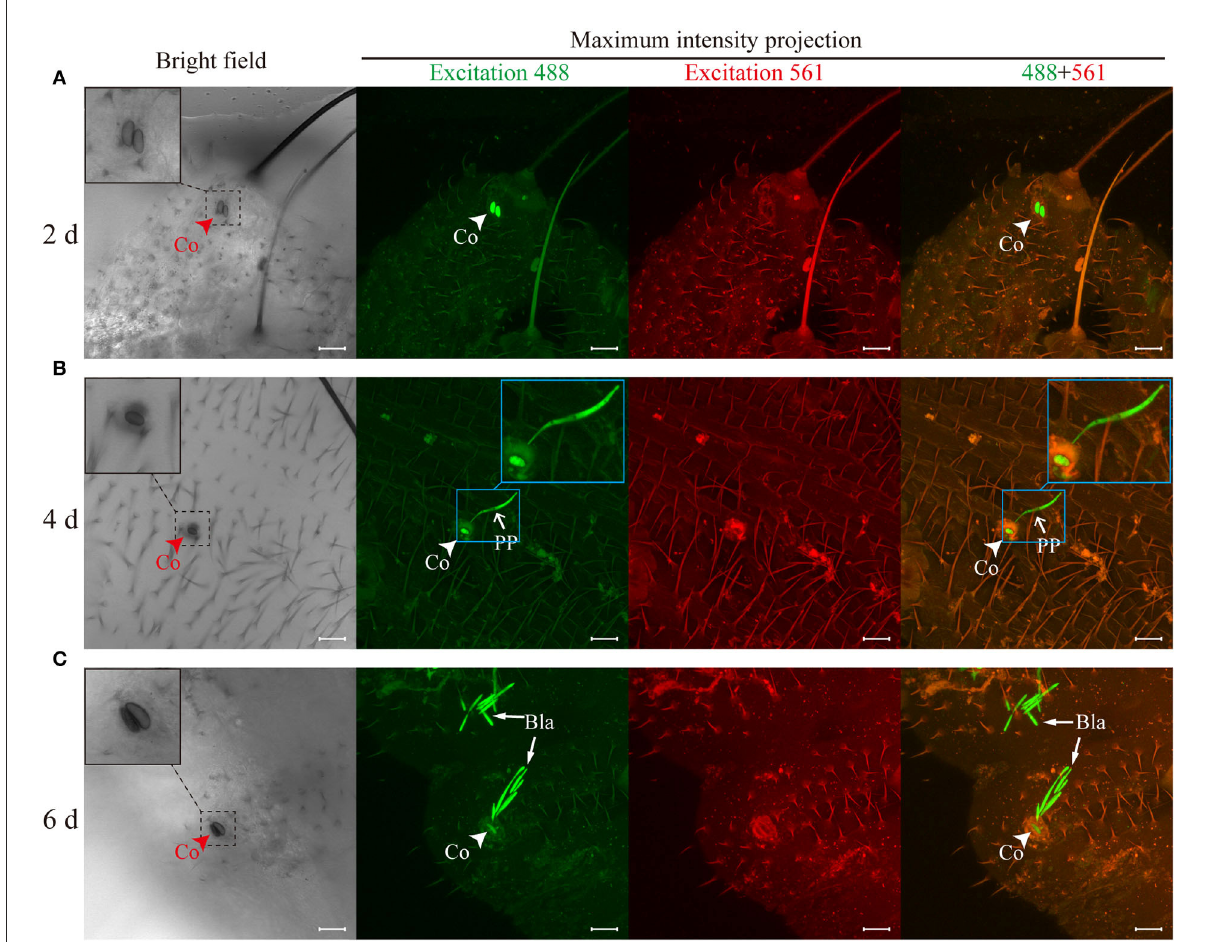
FIGURE3 Ophiocordyceps sinensis invaded Thitarodes xiaojinensis larvae through teguments within 6 days. (A) Conidia attachment to the cuticles was observed after 2 days of inoculation. (B) The germ tubes penetrated the teguments and entered the larval body cavities after 4 days of inoculation. (C) Blastospores were observed in the body cavities of T. xiaojinensis larvae after 6 days of inoculation. The bright-field images were taken on the focal plane of the cuticle attached by conidia. Fluorescent images were maximum intensity projections of z -axial stacks. Green fluorescent images were taken at a 488-nm excitation wavelength. Red fluorescent images were taken at an excitation wavelength of 561nm. In the merged image, the ghost moth cuticle is shown in orange due to the autofluorescence of the cuticle, and O. sinensis is specifically shown in green. Co, conidium; PP, penetration peg; Bla, blastospore. Scale bar, 20 µ m. All photographs were taken by a confocal laser scanning